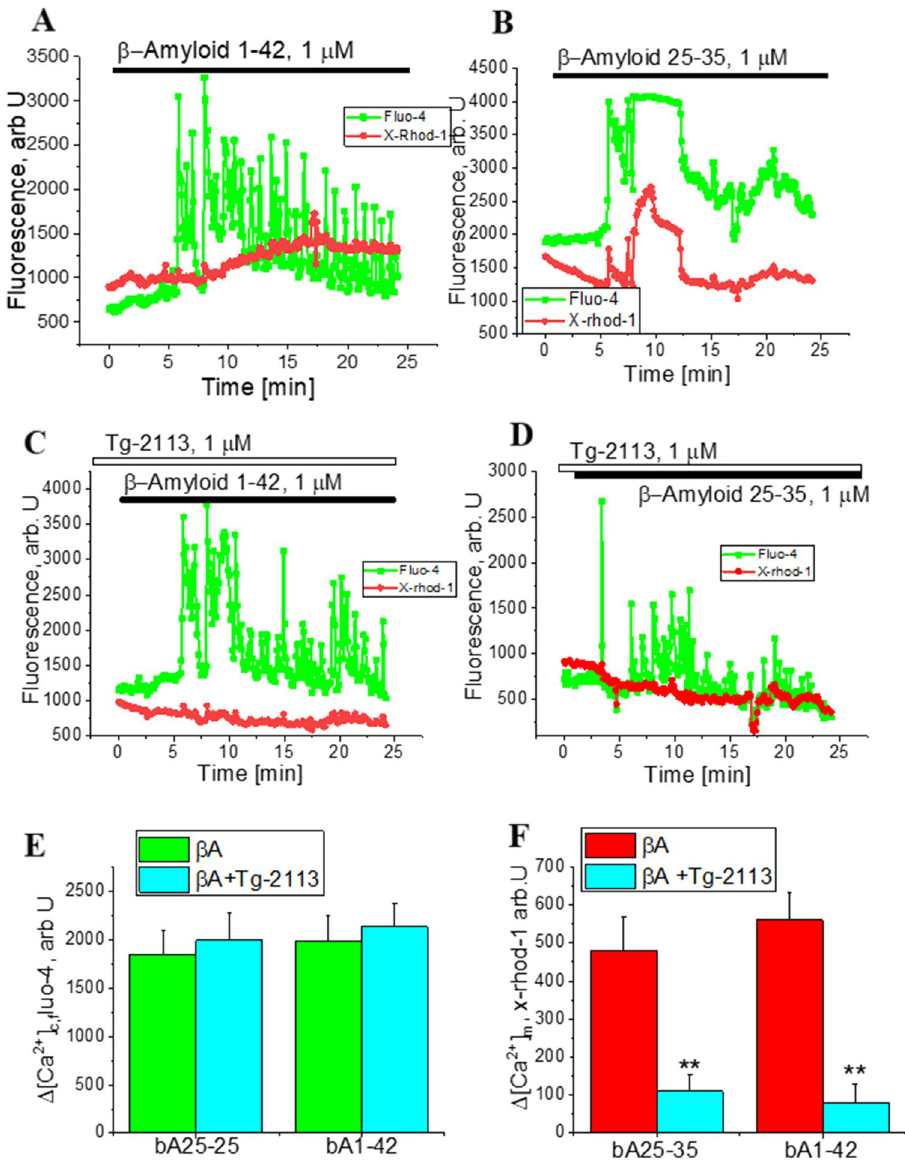
Figure 4. Tg-2113x inhibits mitochondrial calcium uptake but not β-Amyloid-induced calcium signal in cytosol. 1 μM βA (1–42) ( A ) or 5 μM βA (25–35) ( B ) induce an increase in cytosolic (Fluo-4) and mitochondrial calcium (x-Rhod-1). Incubation of the cells with Tg-2113x did not change βA (25–35) -induced cytosolic calcium signal but reduced mitochondrial calcium uptake ( C , D ). ( E ) Amplitude of βA (25–35) -induced changes in Fluo-4 signal with and without incubation with Tg-2113x. ( F ) Changes in mitochondrial Ca 2+ (x-Rhod-1) after application of βA (25–35) or βA (1–42) in control and after incubation with Tg2113x. *p < 0.05; **<